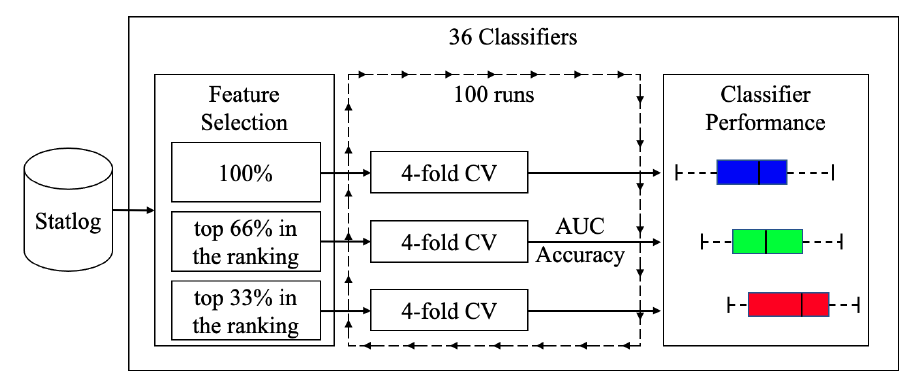
Figure 3. Diagram of the training and testing